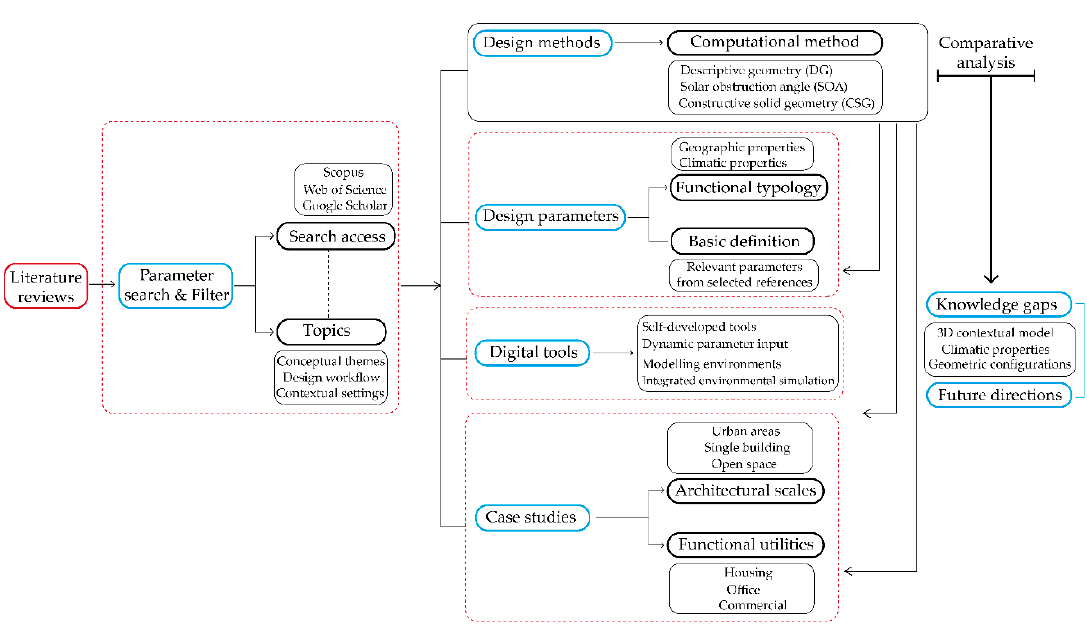
Figure 1. General framework of the review.